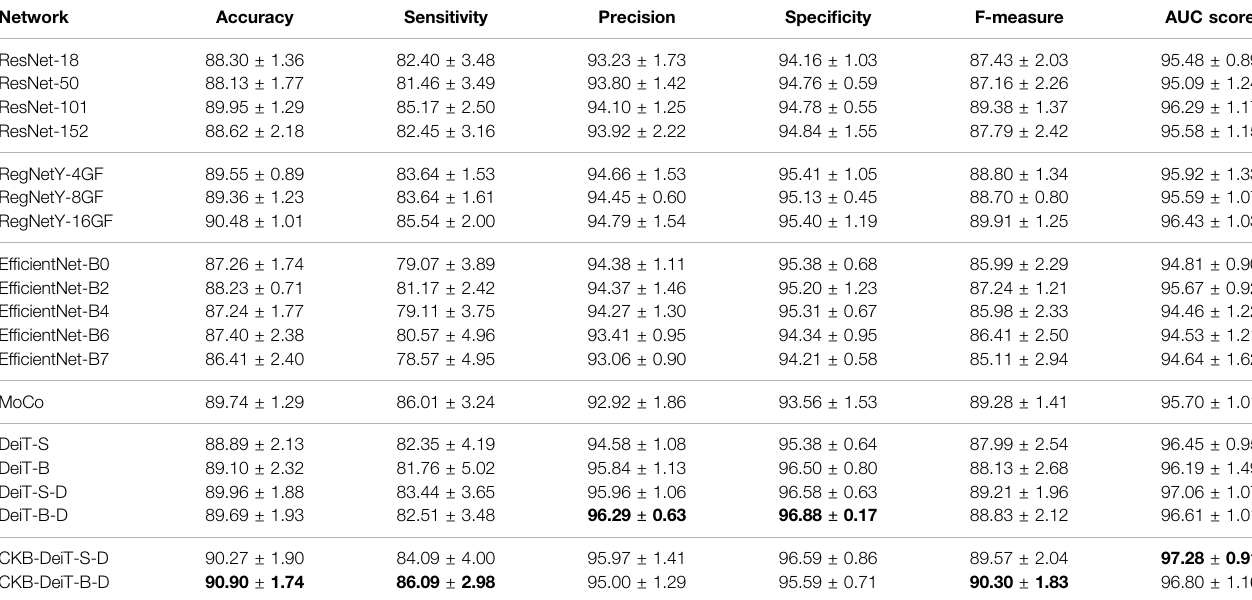
TABLE 2 | Performance of binary classi fi cation on the DFU ischaemia dataset. Network Accuracy Sensitivity Precision Speci fi city F-measure AUC score ResNet-18